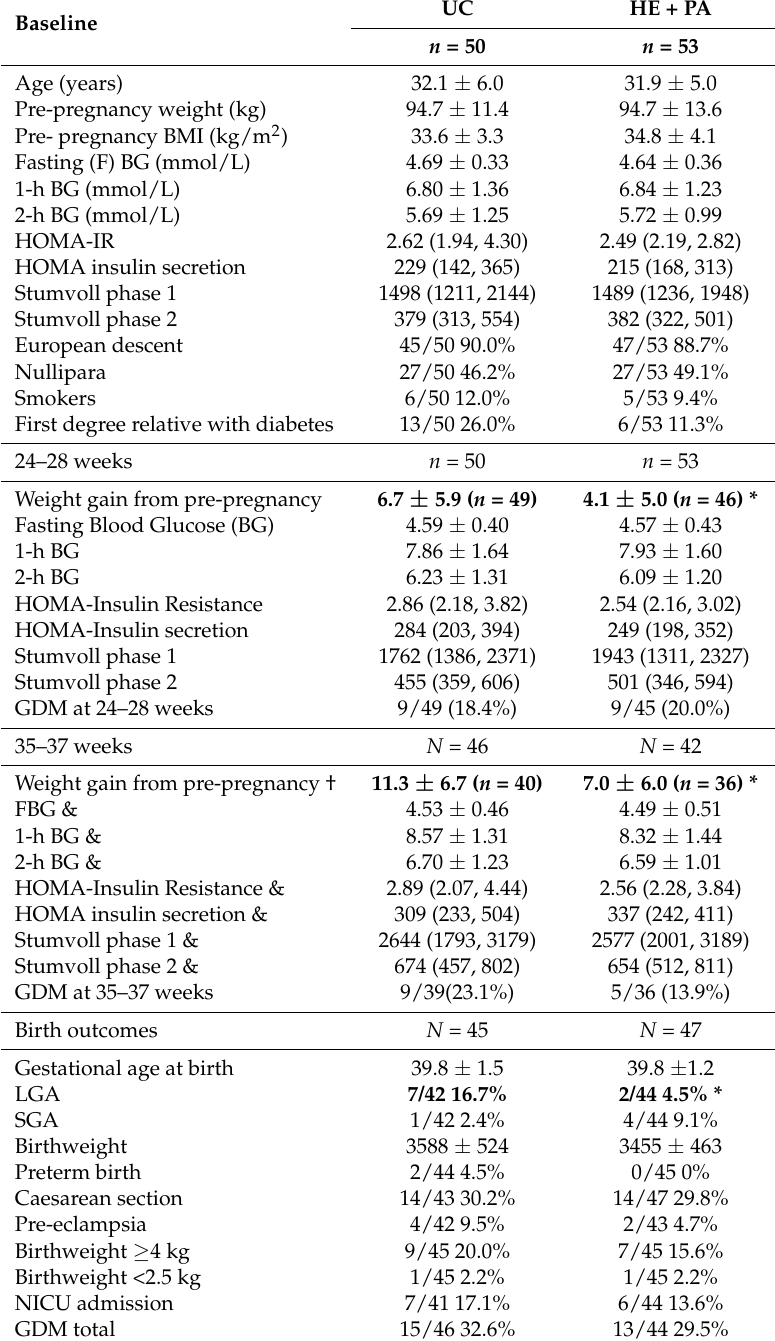
Table 3. Maternal and neonatal characteristics of women at the five DALI sites with maternal gestational weight gain >3 kg difference at 35–37 weeks between healthy eating (HE), and physical activity intervention (HE and PA) and usual care